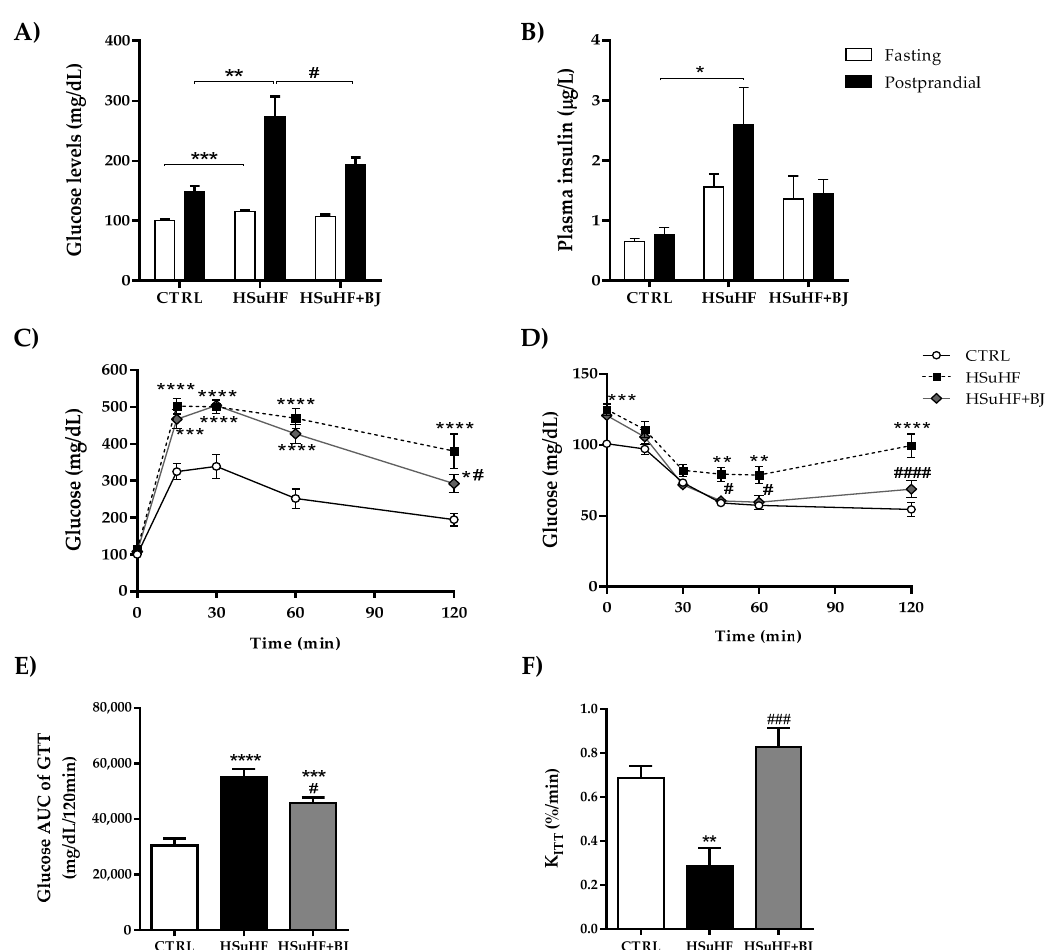
Figure 1. Effects of BJ supplementation on the glycemic and insulinemic profile in HSuHF-fed rats. Fasting and postprandial glucose levels ( A ). Fasting and postprandial insulin levels ( B ). Blood glucose levels throughout the glucose tolerance test (GTT) ( C ); Blood glucose levels throughout the insulin tolerance test (ITT) performed through intraperitoneal injection of insulin (0.75 U/kg body weight) ( D ); area under the curve (AUC) of the blood glucose level during GTT, calculated between baseline and 120 min after glucose bolus (2 mg/kg) ( E ); kITT representing the glucose clearance rate (%min) ( F ) in CTRL, HSuHF, and HSuHF + BJ groups. Results are expressed as the mean ± SEM. ( n = 8–10/group; in fasting insulin levels: n = 3–4/group were used); * p < 0.05, ** p < 0.01, *** p < 0.001, and **** p < 0.0001 vs. CTRL; # p < 0.05, ### p < 0.001, and #### p < 0.0001 vs. HSuHF. CTRL: control. HSuHF: high sucrose / high-fat. BJ: blueberry juice.